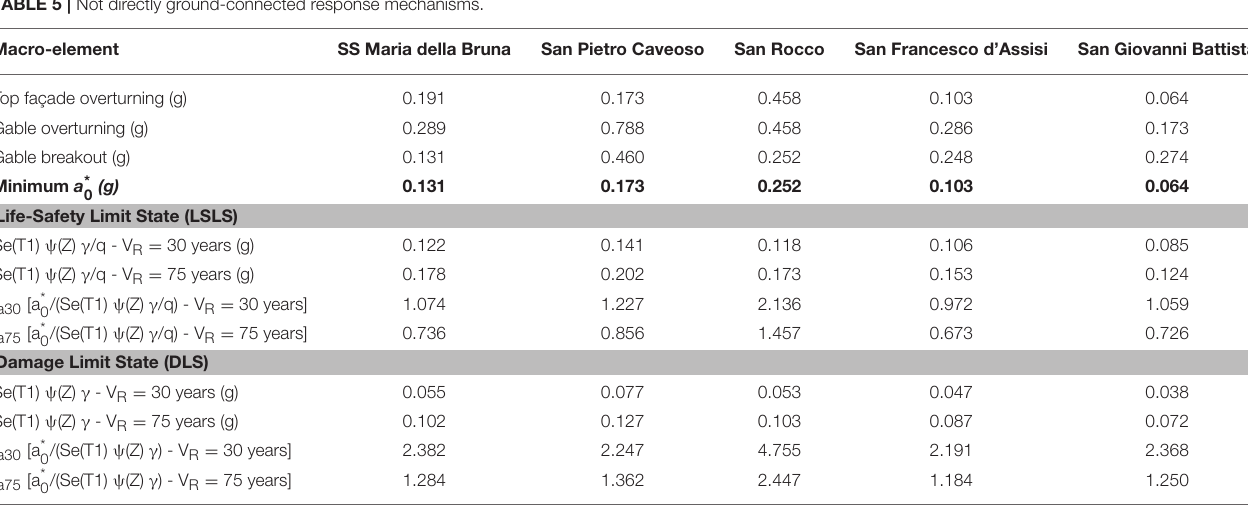
TABLE 5 | Not directly ground-connected response